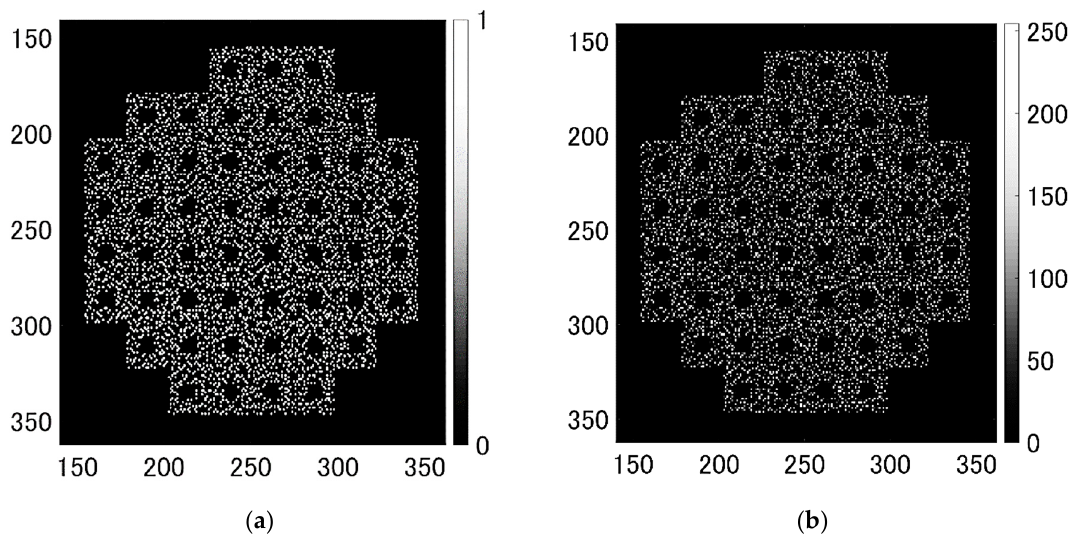
Figure 3. ( a ) Original pattern of signal area; ( b ) intensity distribution of reconstructed signal area. (omitting unnecessary interference).